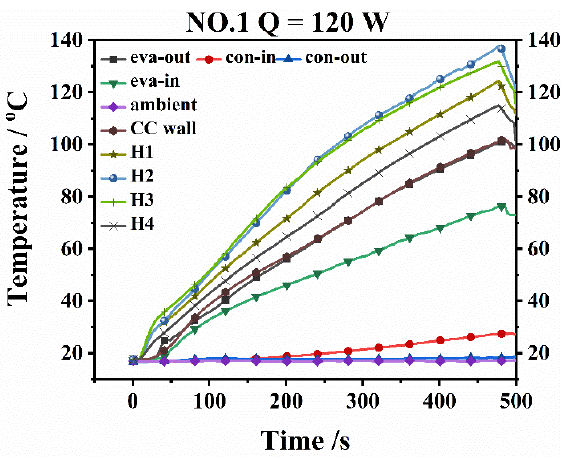
Figure 8. Temperature response during startup process of No.1 position at 120 W.